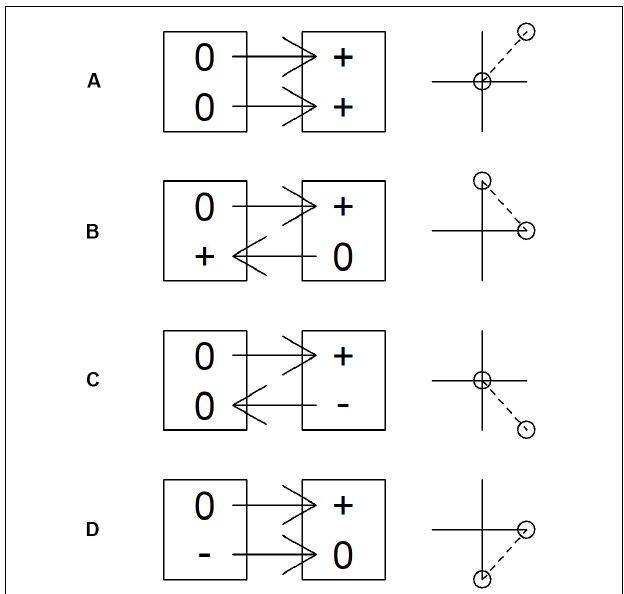
FIGURE 6 | Spurious relationships resulting from simultaneous changes in species populations. Boxes represent habitats or census locations. 0, + and – represent change in population during a one year period for two species. The ‘correlation’ plot to the right represents relationships that emerge from a ‘change versus change’ analysis of the process illustrated. (A) Species share preferred habitat/core area and expand into marginal habitats/areas. (B) Species differ in preferred habitat/core area and expand into marginal habitats/areas. (C) Species share the same preferred habitat/core area and one expands into while another contracts from marginal habitat/areas. (D) Species differ in preferred habitat/core area and one expands while another contracts from marginal